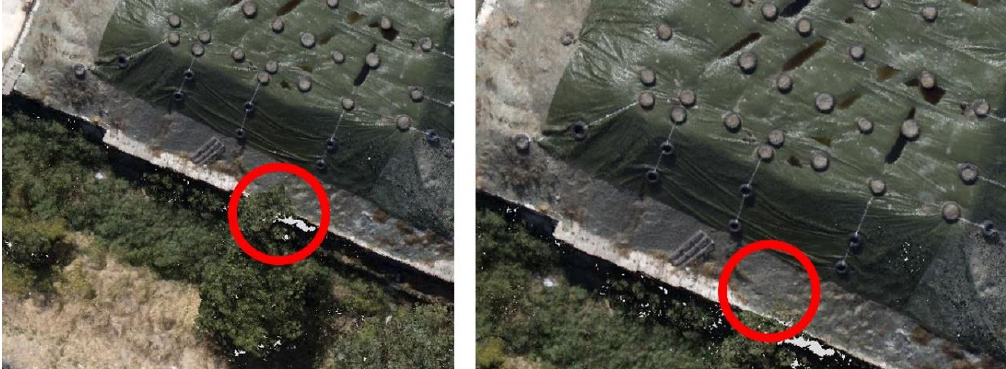
Figure 16. Dense cloud cleaning before DEM generation.